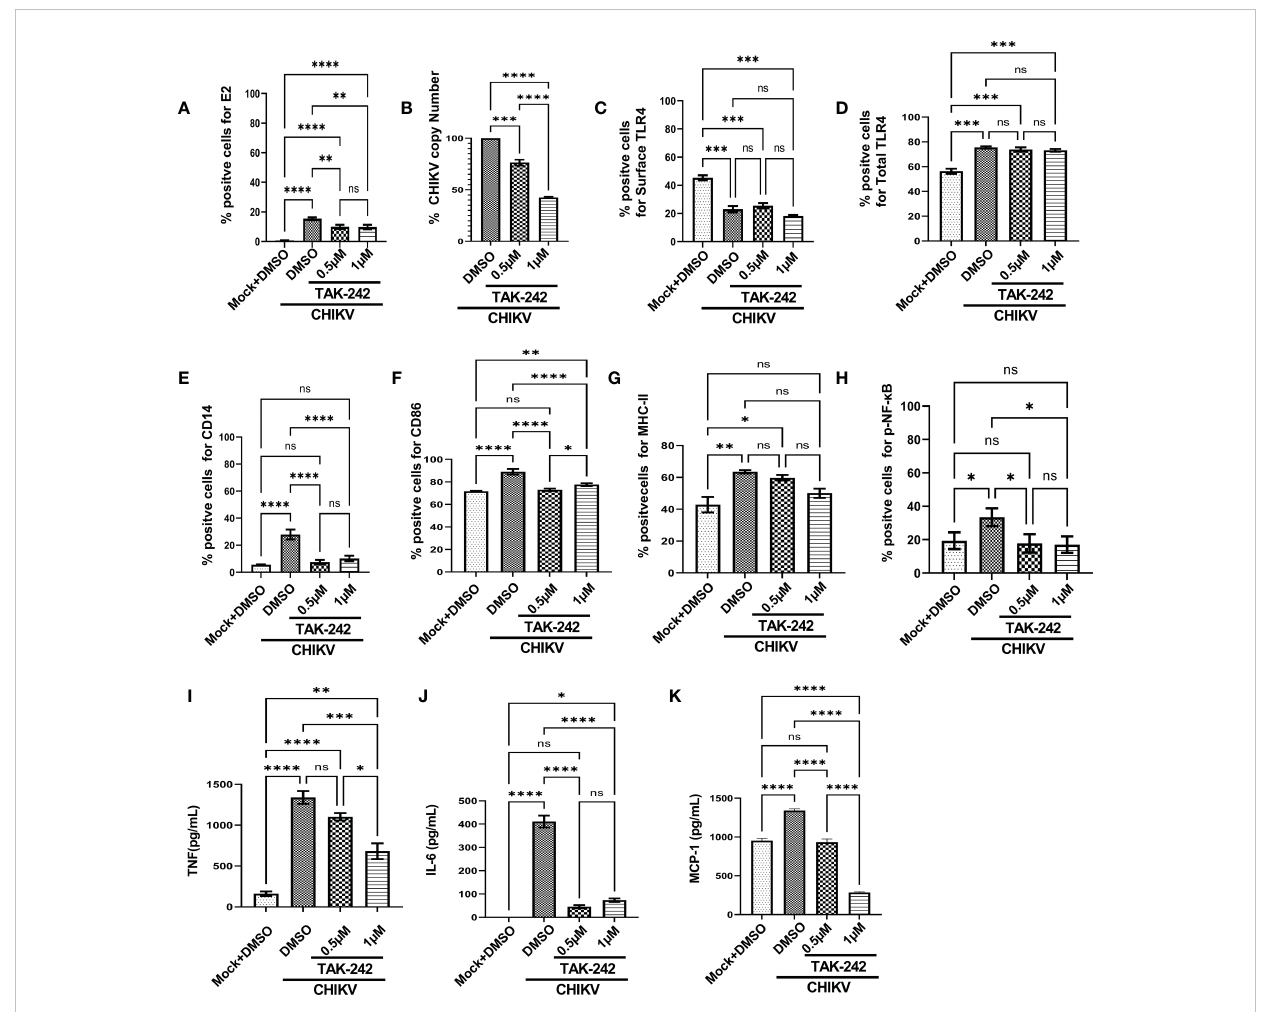
FIGURE 1 TLR4 inhibition decreases CHIKV infection and pro-in fl ammatory responses in RAW264.7 macrophage cells, in vitro . The RAW264.7 cells were either pre-treated with DMSO or TAK-242 for 3 h before CHIKV infection. CHIKV infection was given at 5 MOI for 2 h followed by the cells were harvested at 8 hpi. (A) The bar diagram denotes fl ow cytometry dot plot analysis based on % positive cells for CHIKV-E2, (B) q-RT PCR-based analysis showing decreased CHIKV-E1 copy number in presence of TAK-242. The bar diagrams represent percent positive cells obtained by fl ow cytometry dot plot analysis for (C) surface TLR4, (D) total TLR4, (E) CD14, (F) CD86 and (G) MHC-II and (H) p-NF- k B expression. (I – K) ELISA-based cytokine analysis showing differential expression of TNF- a , IL-6 and MCP-1. Data represent the Mean ± SEM of three independent experiments. p < 0.05